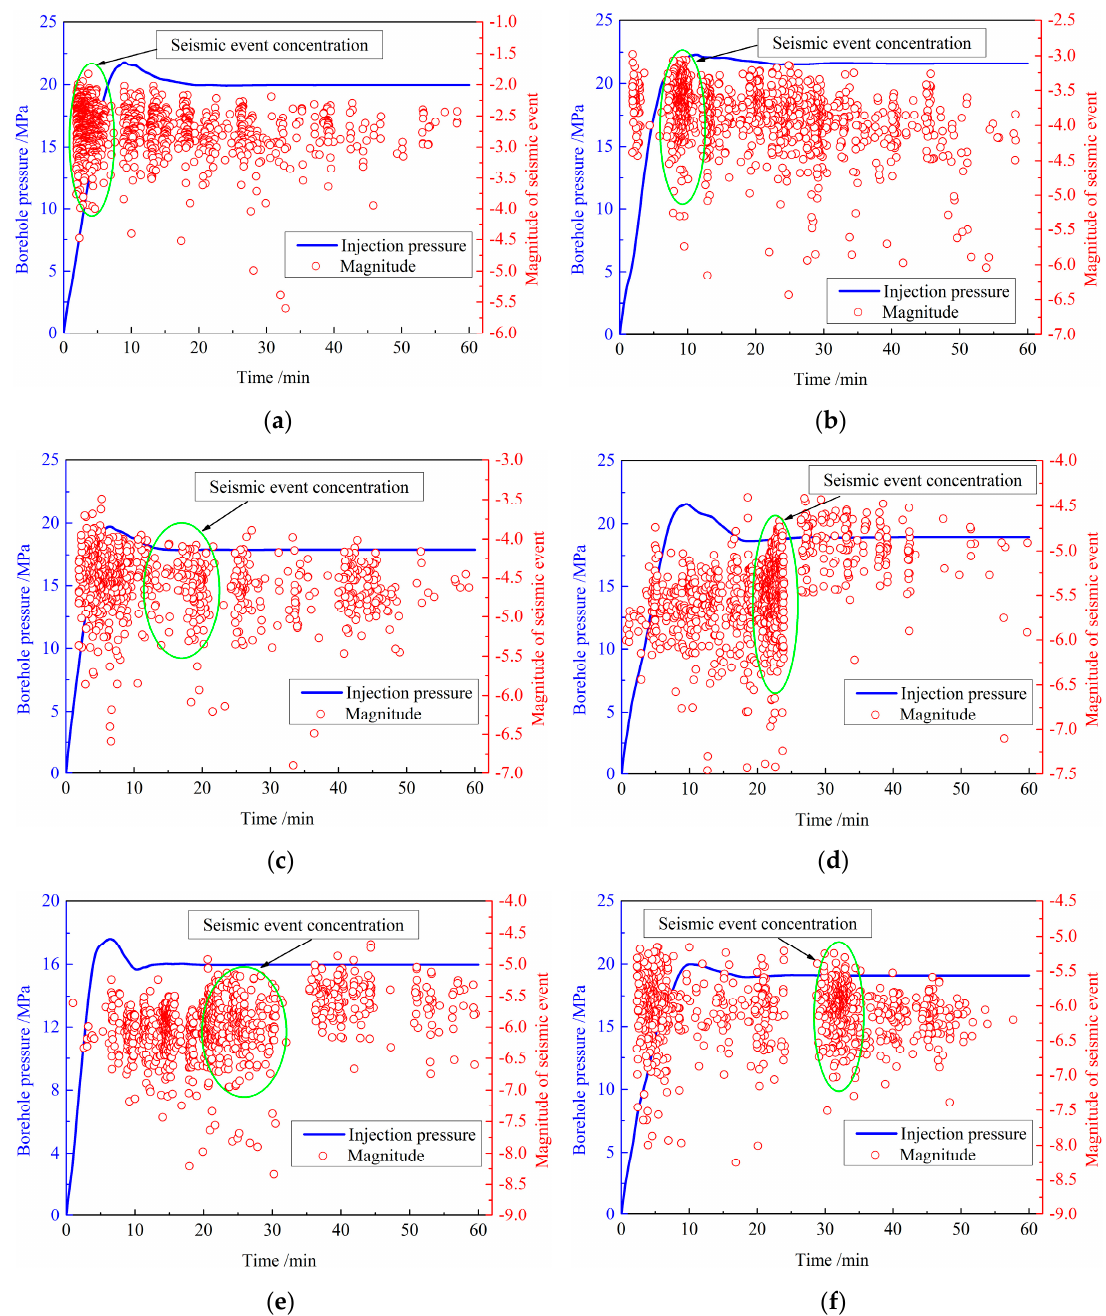
Figure 17. Variations in borehole pressure and magnitude of seismic events when the distance between